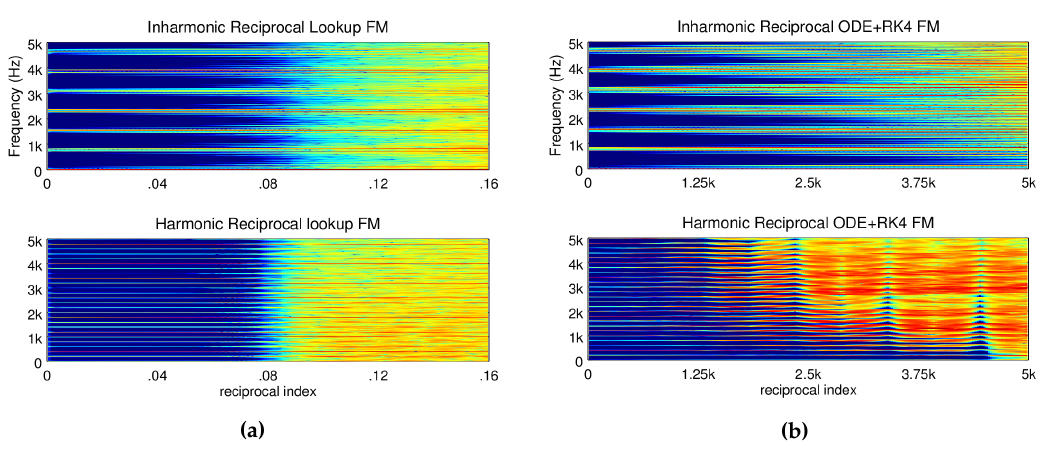
Figure 5. Spectrograms of ( a ) reciprocal frequency modulation using lookup oscillators of frequencies 800 Hz and 777 Hz in the top and 800 Hz and 600 Hz in the bottom; In ( b ) the same network with the same frequencies, but using the ODE (ordinary differential equation) + RK4 implementation. In all four plots the modulation index of the 800 Hz oscillator is held fixed while the other modulation index is swept upwards.